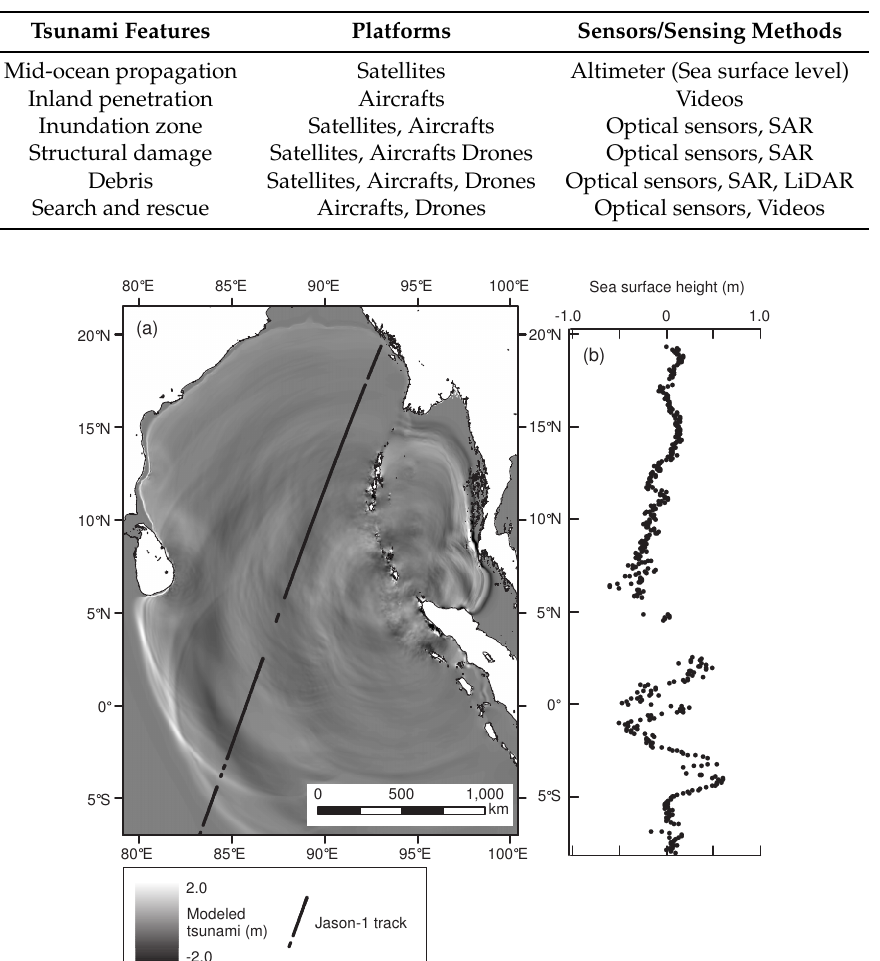
Table 1. Tsunami features acquired with remote sensing platforms and sensors.